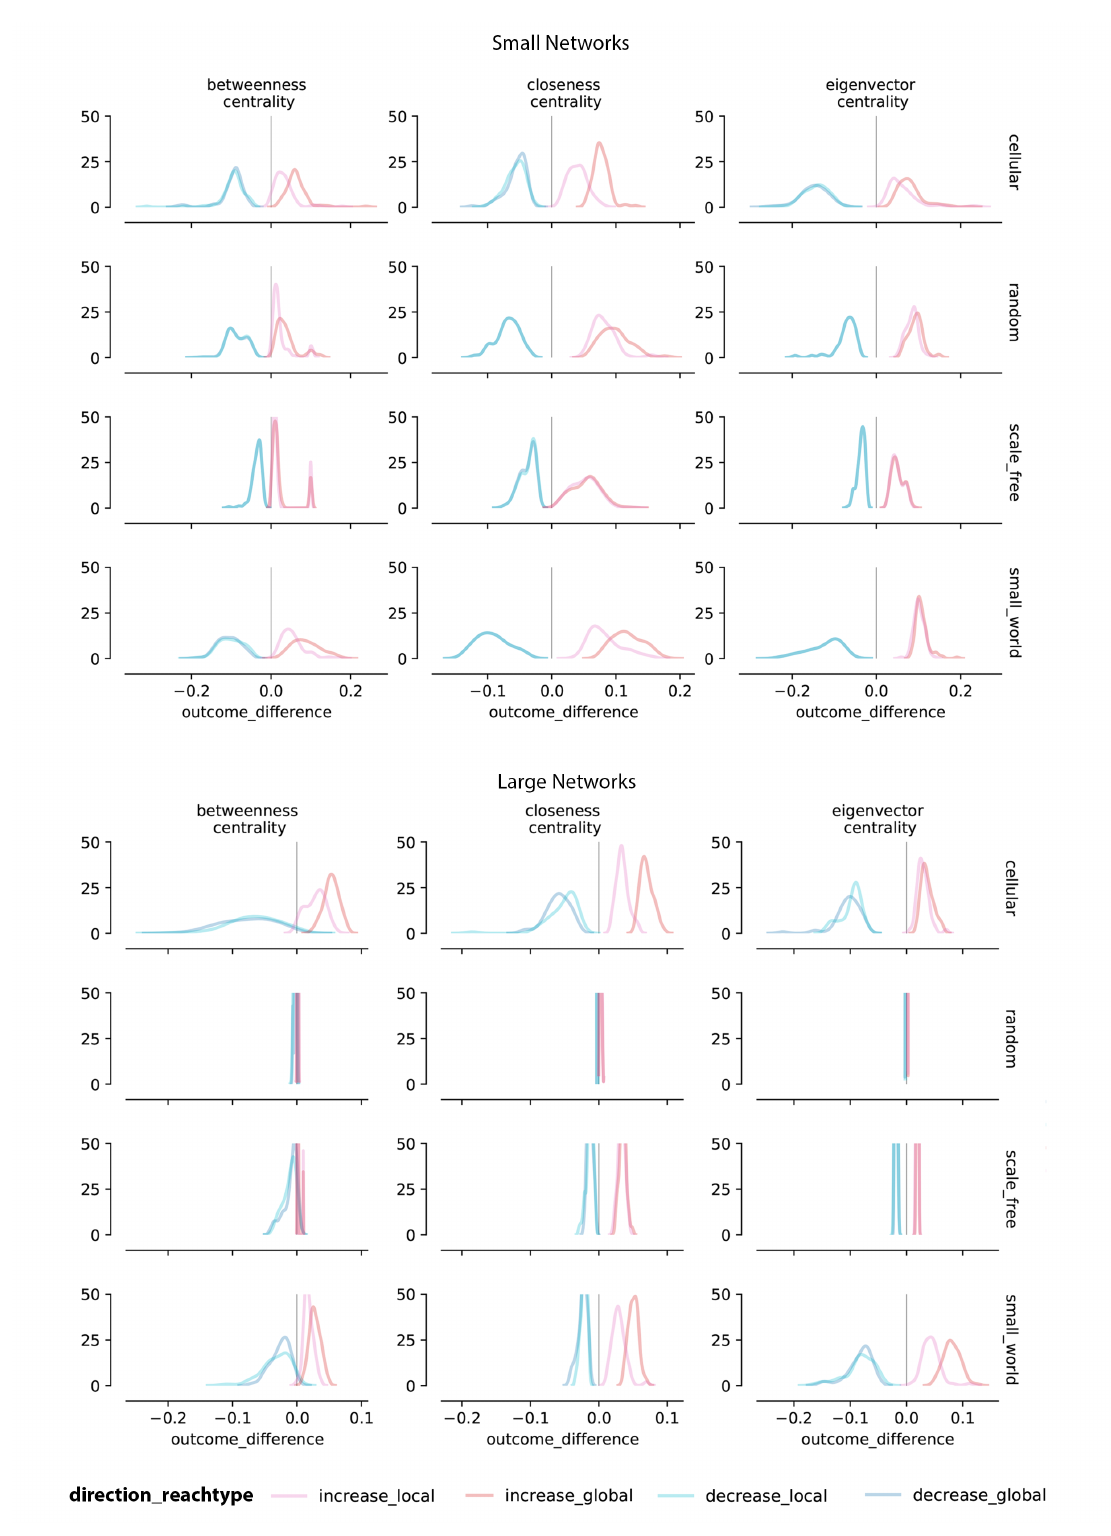
Figure 7. Distribution of changes in centrality measures (outcome_difference) of the target node before and after an attack across 50 randomly generated small (20 nodes) and large (200 nodes) synthetic networks per topology (row). Colors represent directionality, reach type, and size per experiment, as shown in the